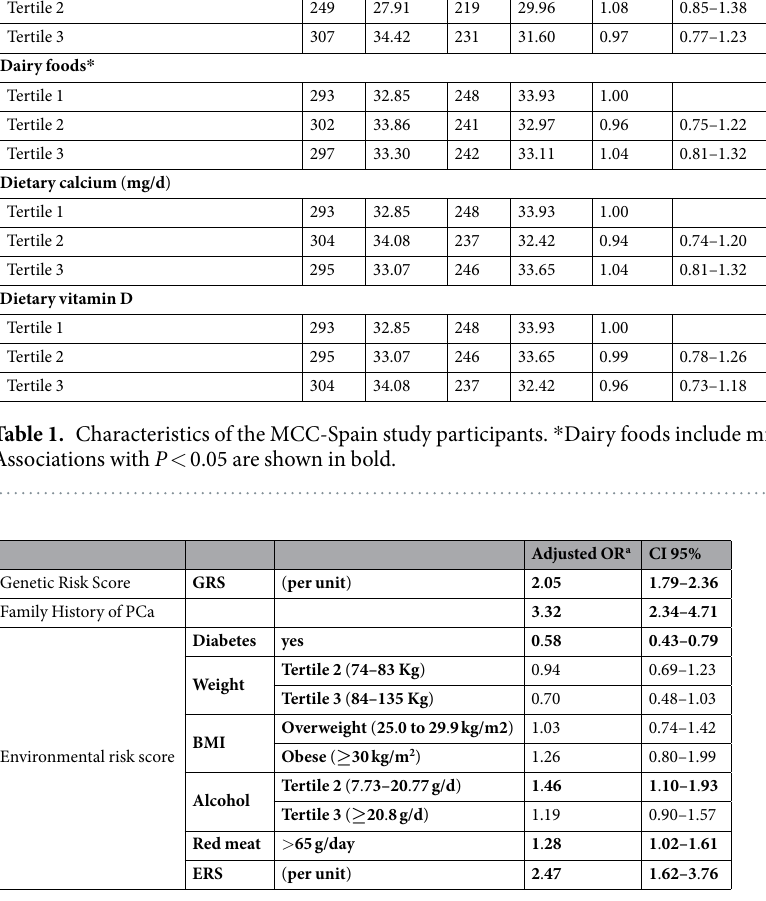
Table 2. Multivariate-adjusted risk factors associated with PCa. GRS: genetic risk score; ERS: environmental risk score; BMI: body mass index. aAll variables are adjusted by propensity score and all the variables shown in the table. Associations with P < 0.05 are shown in bold.